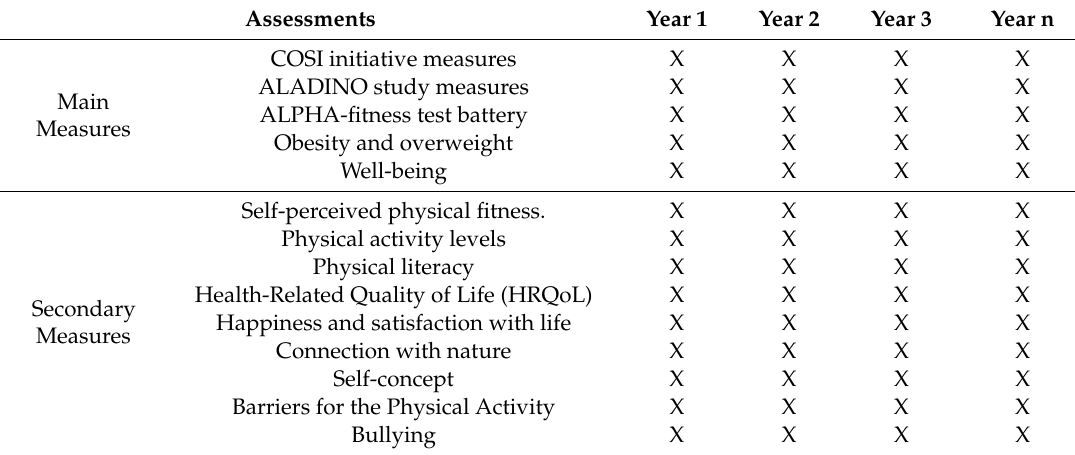
Table 1. Assessments